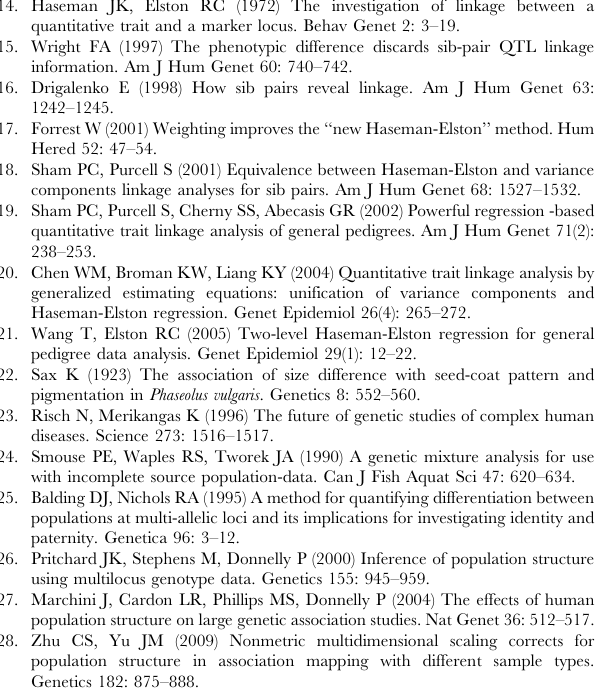
Table S4 Effect of the number of alleles on multi-QTL mapping in the third simulation experiment (200 replicates).